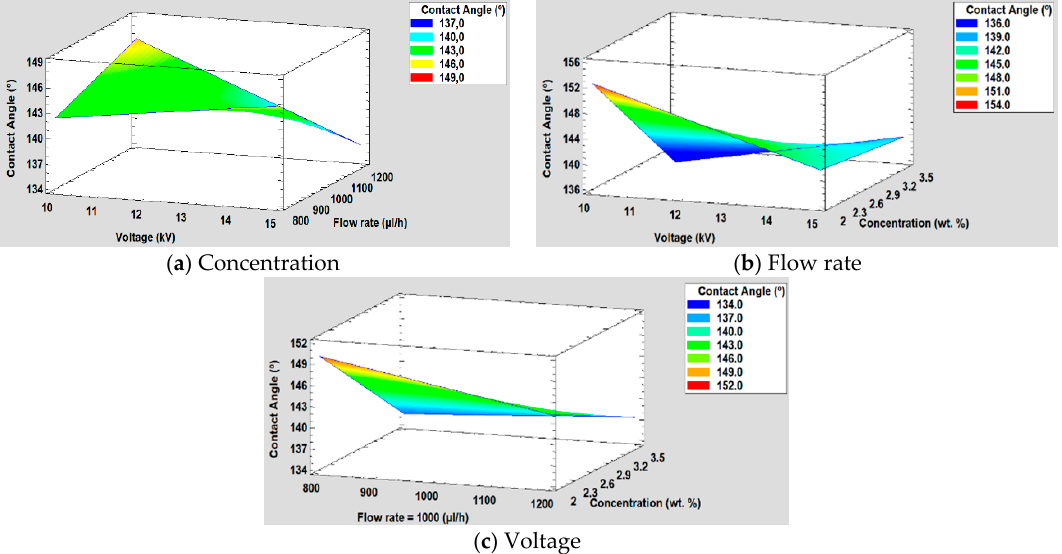
Figure 14. ( a ) Concentration, ( b ) Flow rate and ( c ) Voltage surface response in the water contact angle.